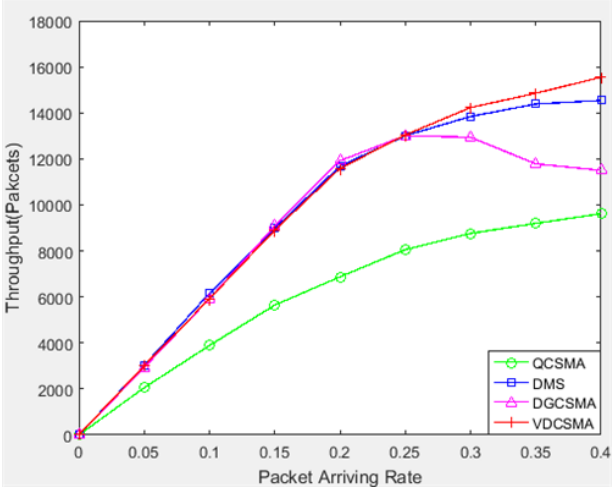
Figure 4. Total throughput: λ ∈ [ 0,0.4 ]